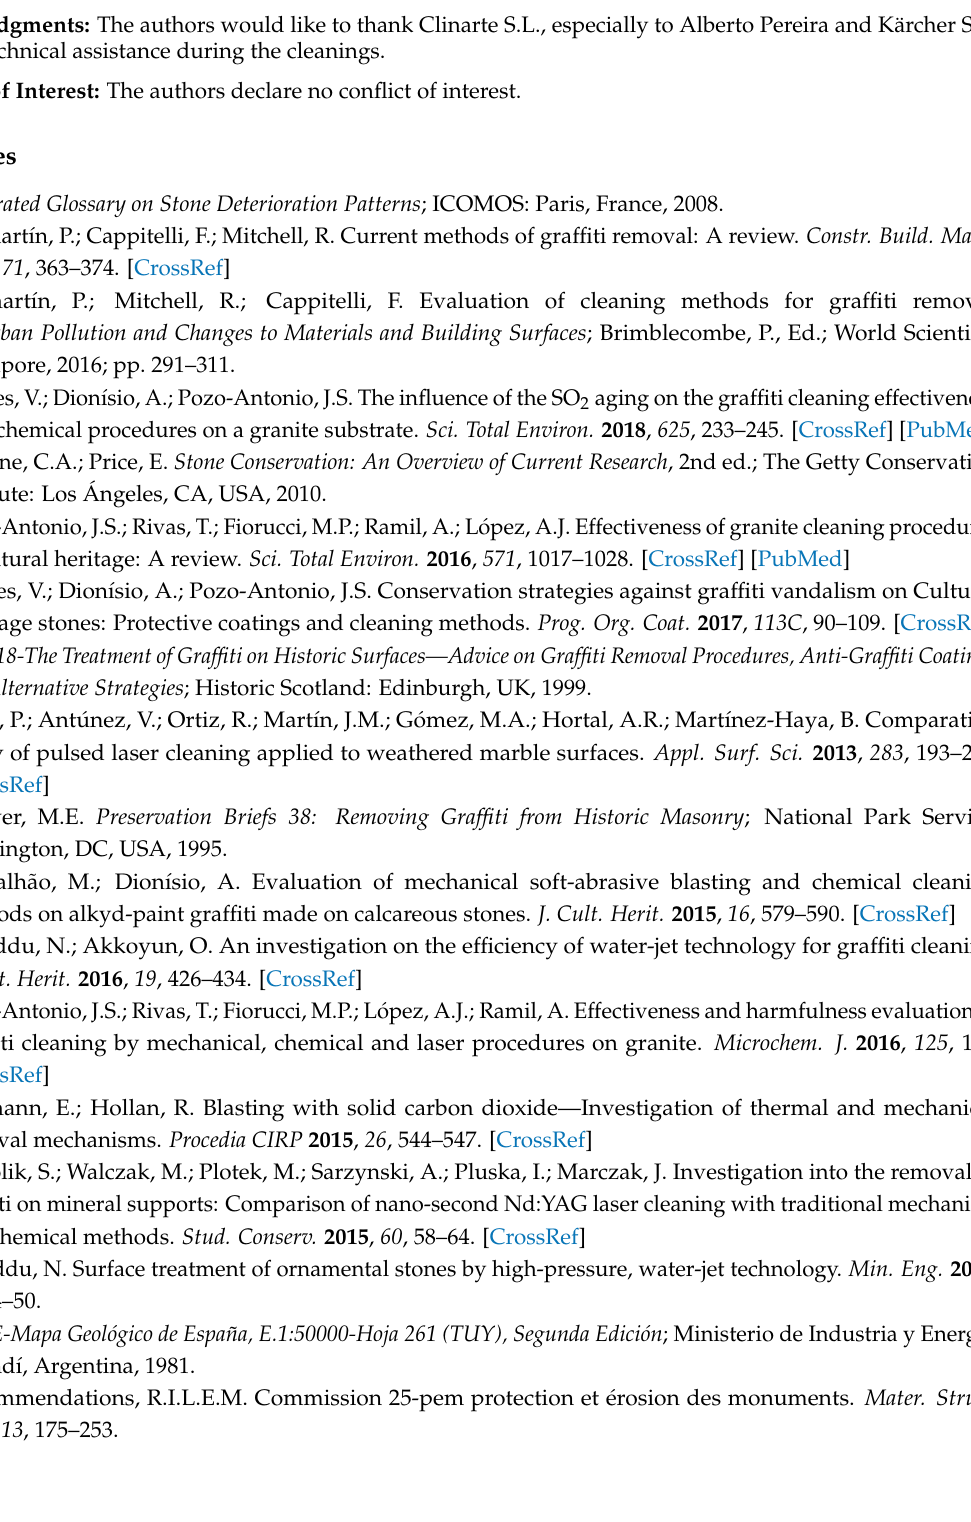
Table S1: R a ± DS ( µ m) of the cleaned